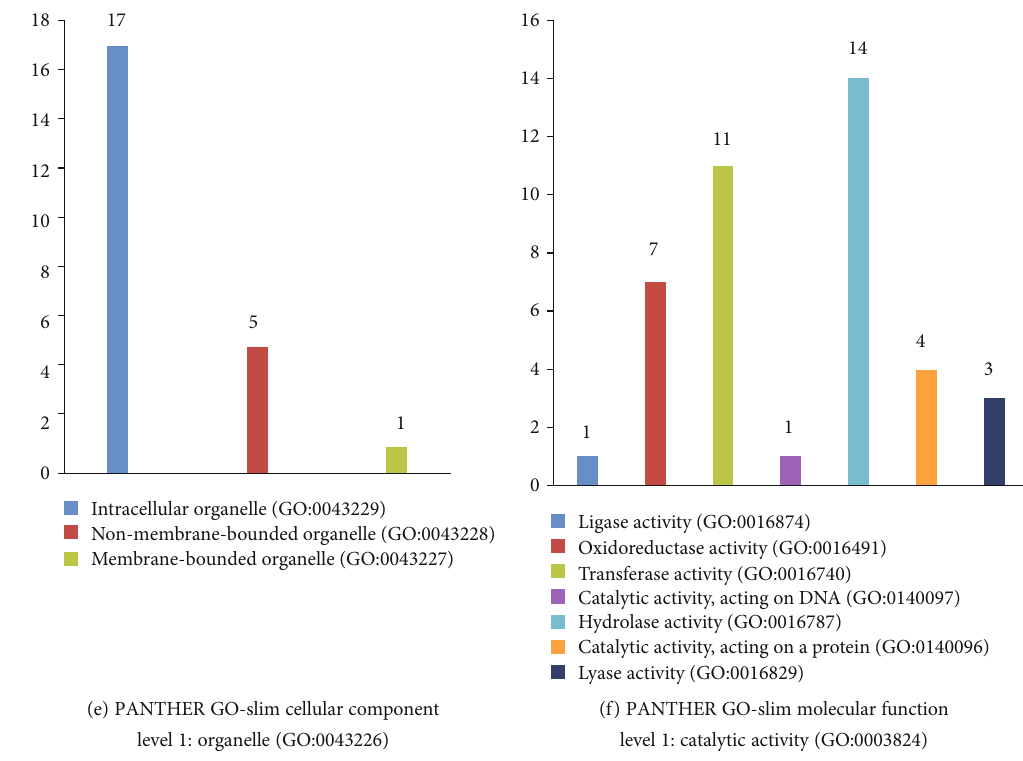
Figure 4: PANTHER GO-Slim classi fi cation of high-con fi dence target genes under the heat stress. The vertical axis represents the number of high-con fi dence target